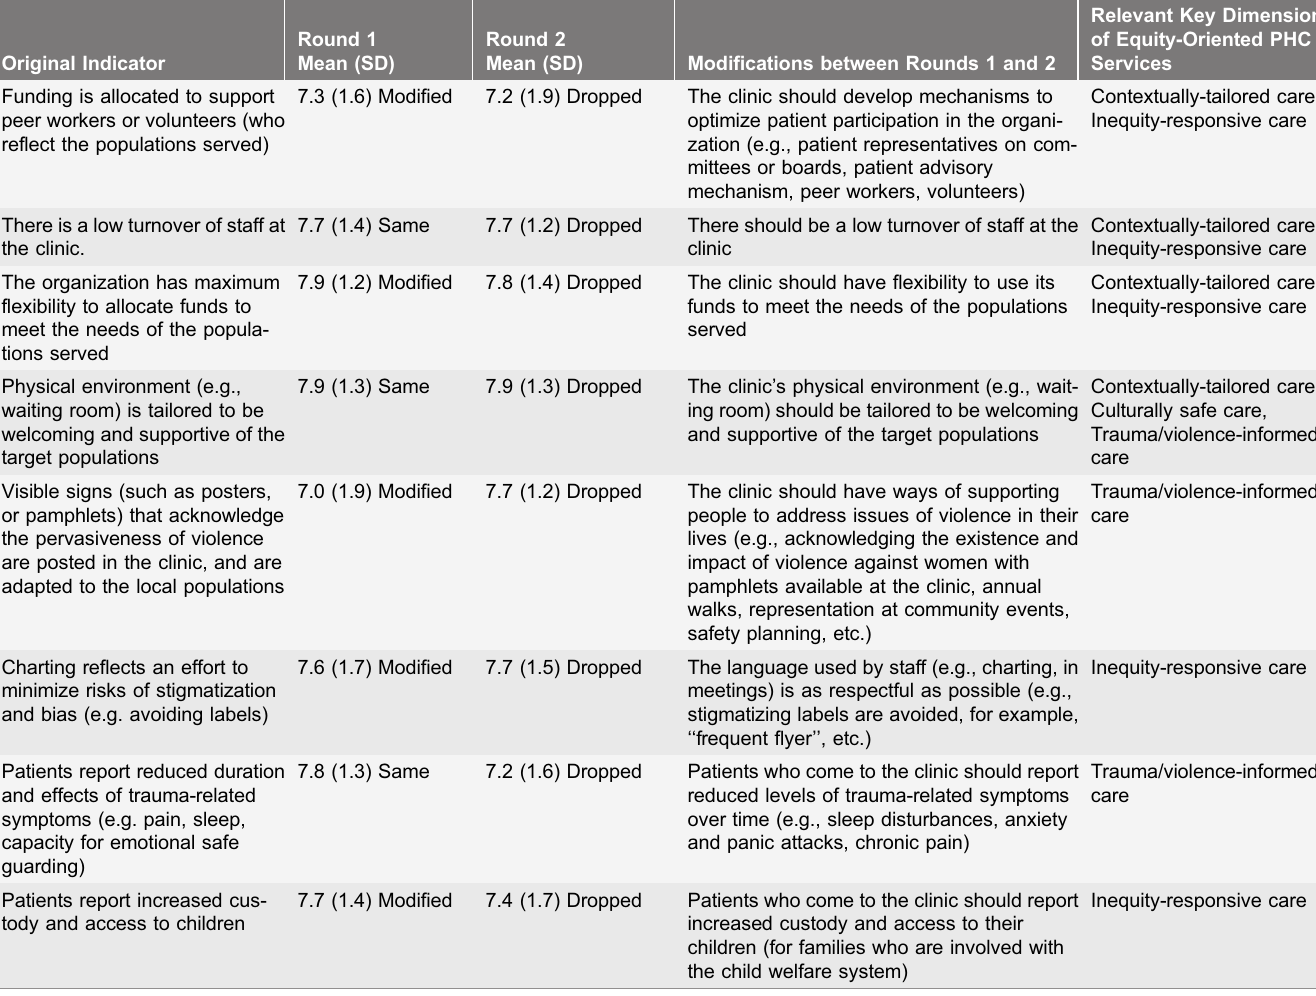
Table 3. Potential Health Equity Indicators that were dropped after Round 2.